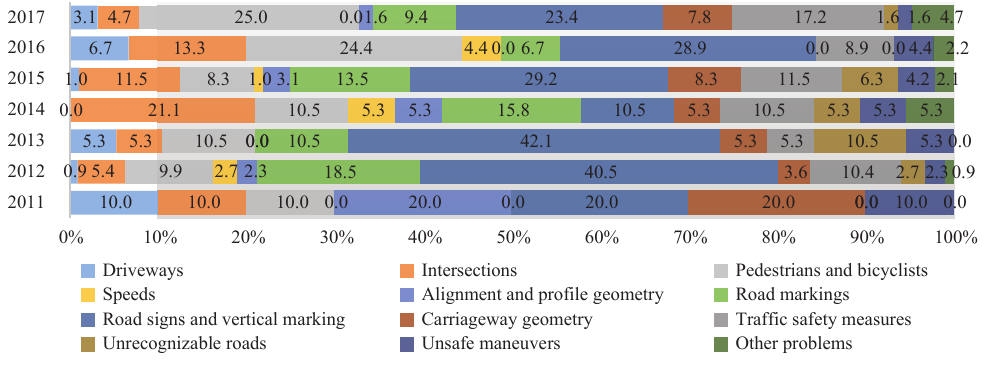
Figure 5. The occurrence frequency of each problem category at any given year for